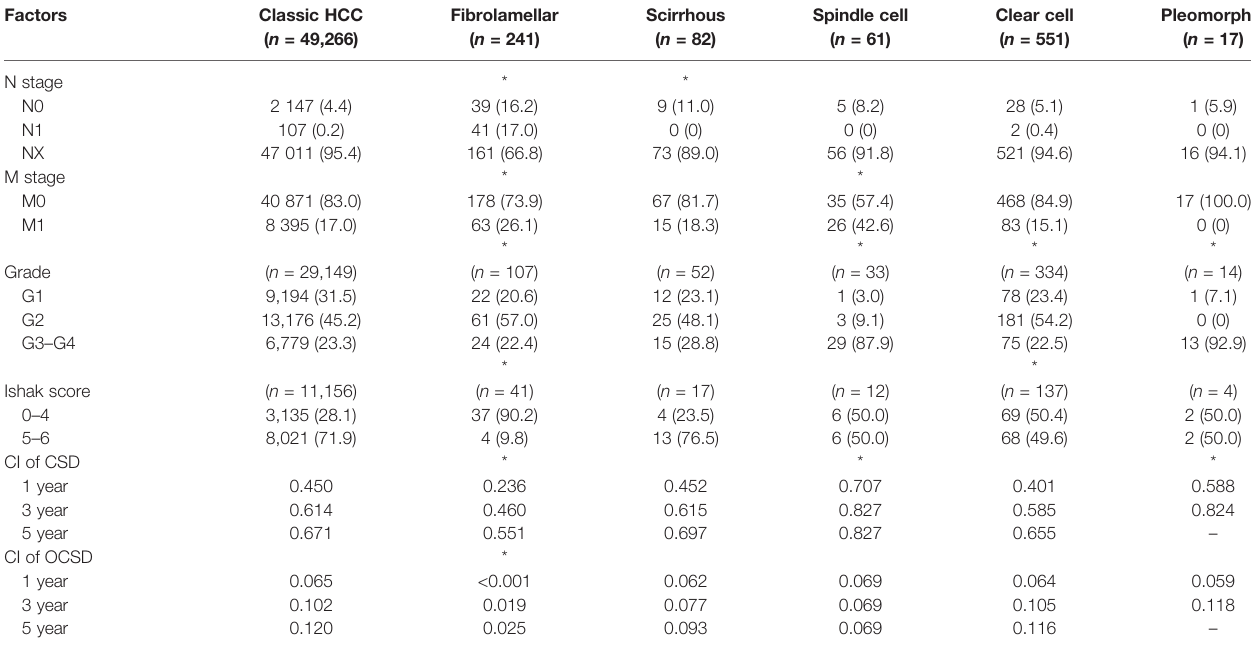
analyzed in subtypes with a suf fi cient sample size. For patients with classic HCC, the LND group did not show better prognoses than the non-LND group ( Supplementary Table S2 and Figure 5B ; P = 0.676) after PSM, which also applied to